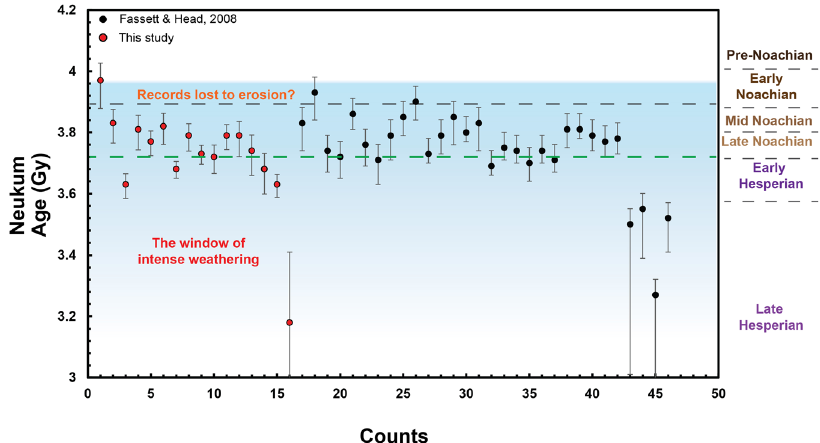
Fig. 10 A summary of the age constraint of weathering sequences compared to the age of valley network formation. The red dot represents the crater- counting age constraint of weathering sequences (Supplementary Table 2 and Supplementary Figs. 2 – 18). The black dot indicates the ages for the cessation of valley networks. Model age errors are + / − 1-sigma error on the model fi t for N(1). Period boundary (green line) is as de fi ned by Werner and Tanaka 91 . Prior to ~3.9 Ga, the planet was likely too geologically active to retian much of the geologic record of chemical weathering or sedimentary